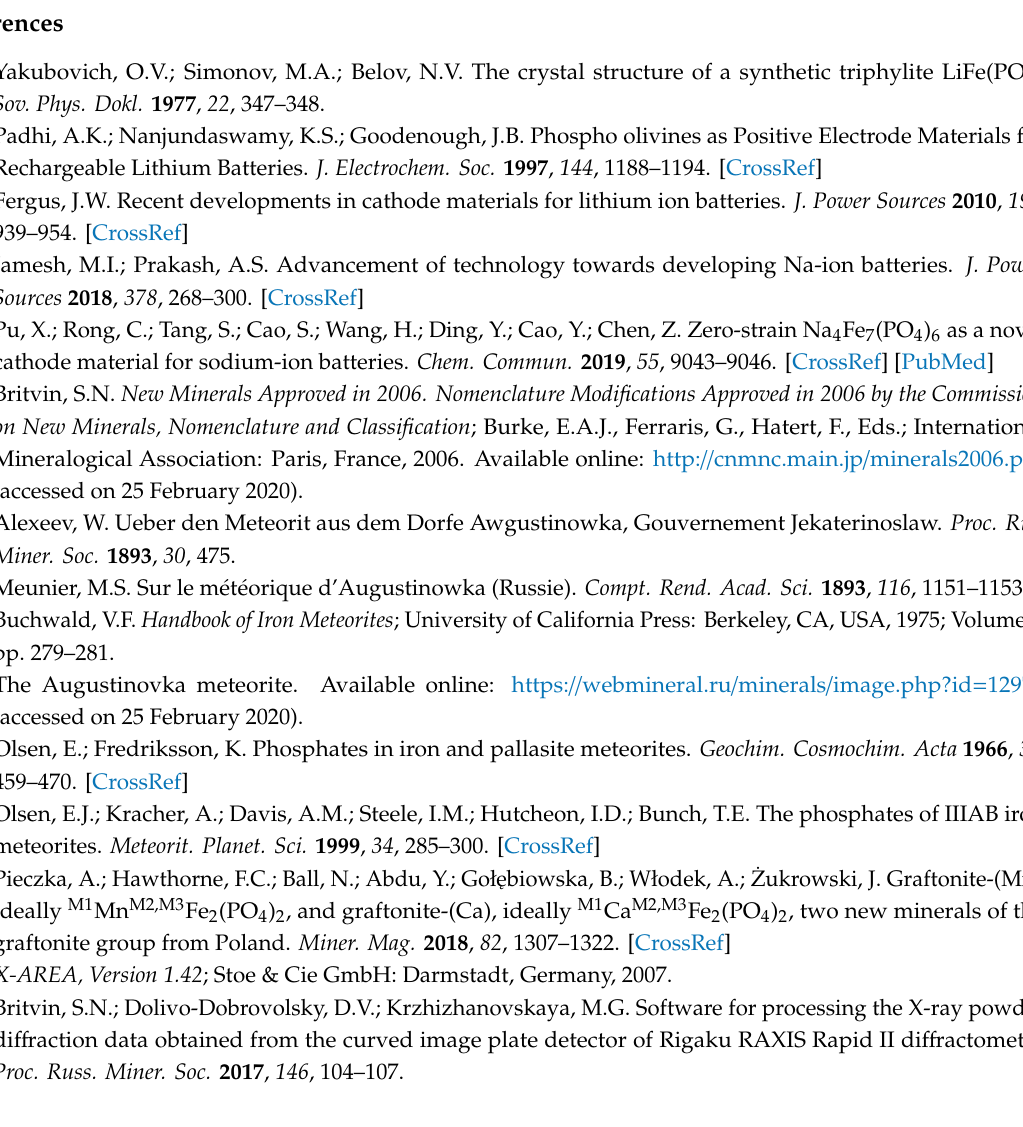
Figure S1: As-recorded imaging plate pattern of xenophyllite. Rigaku RAXIS Rapid II di ff ractometer, semi-cylindrical imaging plate, CoK α -radiation (rotating anode with microfocus optics), 40 kV acceleration voltage, 15 mA tube current, 127.4 mm detector-to-crystal distance, 60 min exposure time. The black rectangle outlines the area used for the integration of imaging plate data into an XRD profile., Figure S2: Powder XRD profile of xenophyllite obtained by integration of imaging plate data shown in Figure